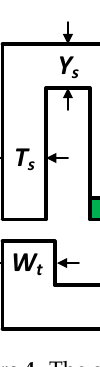
Figure 4. The analyzed geometric variables.